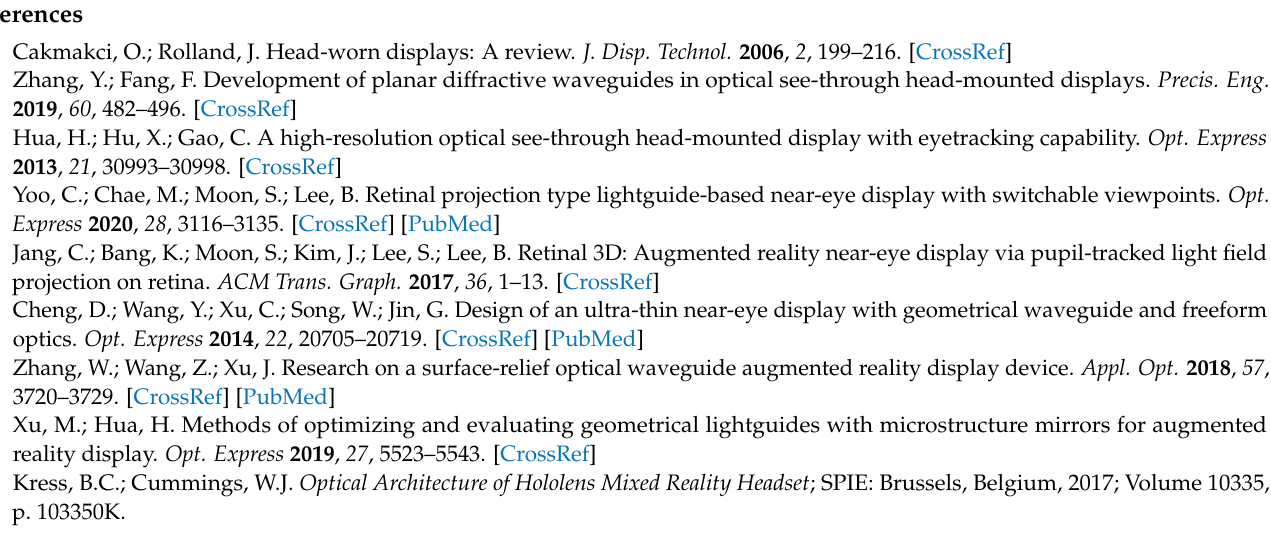
Holographic display (Refs.